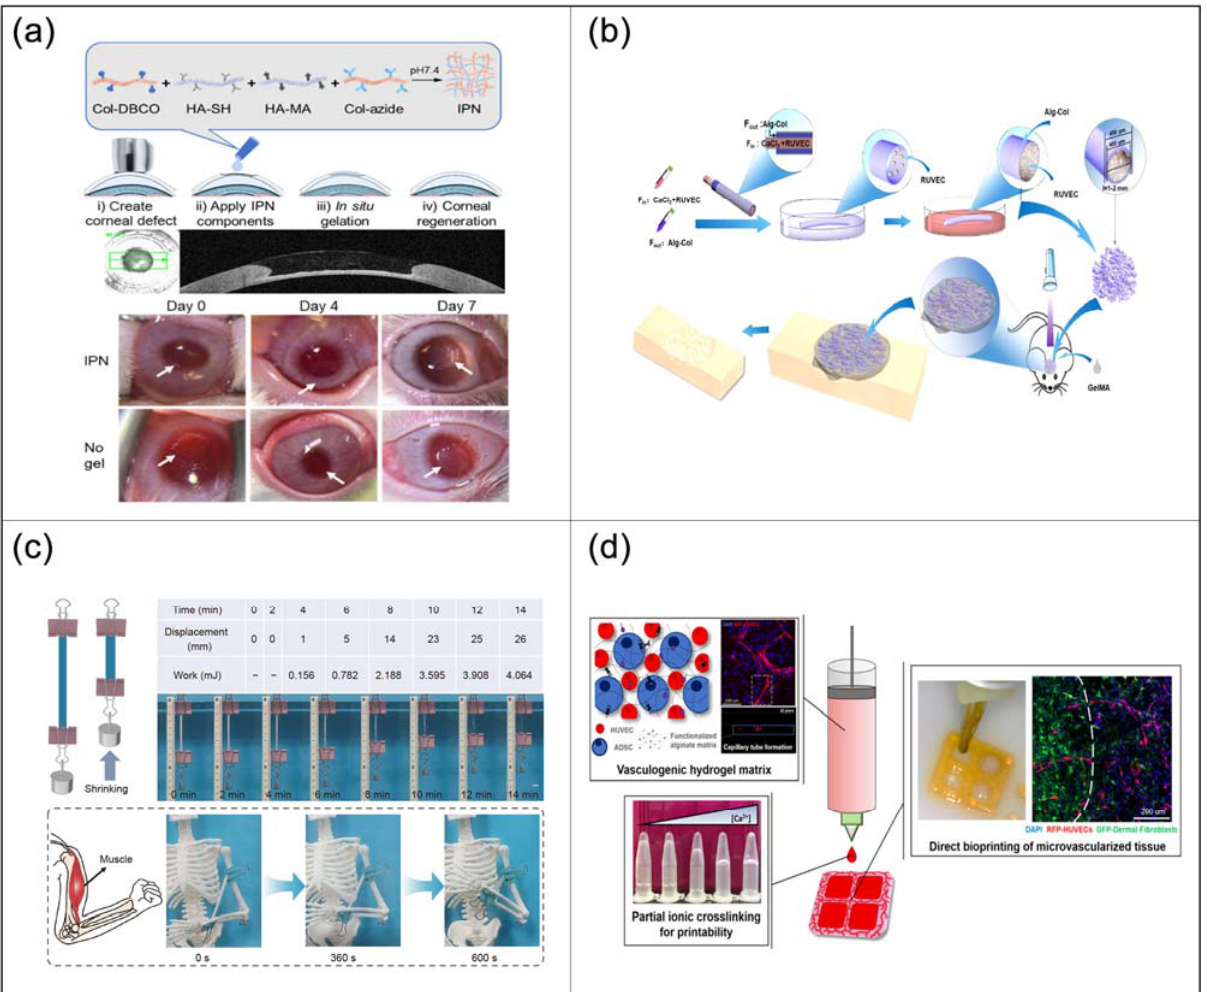
Figure 2. Applications of CHs in regenerative medicine and artificial organs. ( a ) Ex vivo and in vivo studies of the application of the IPN as a corneal defect filler. ( b ) Schematic illustration of the fabrication and application of BMVs loaded with RUVECs. ( c ) Application experiment of artificial muscle. ( d ) Printing artificial blood vessels using hydrogel bioinks.